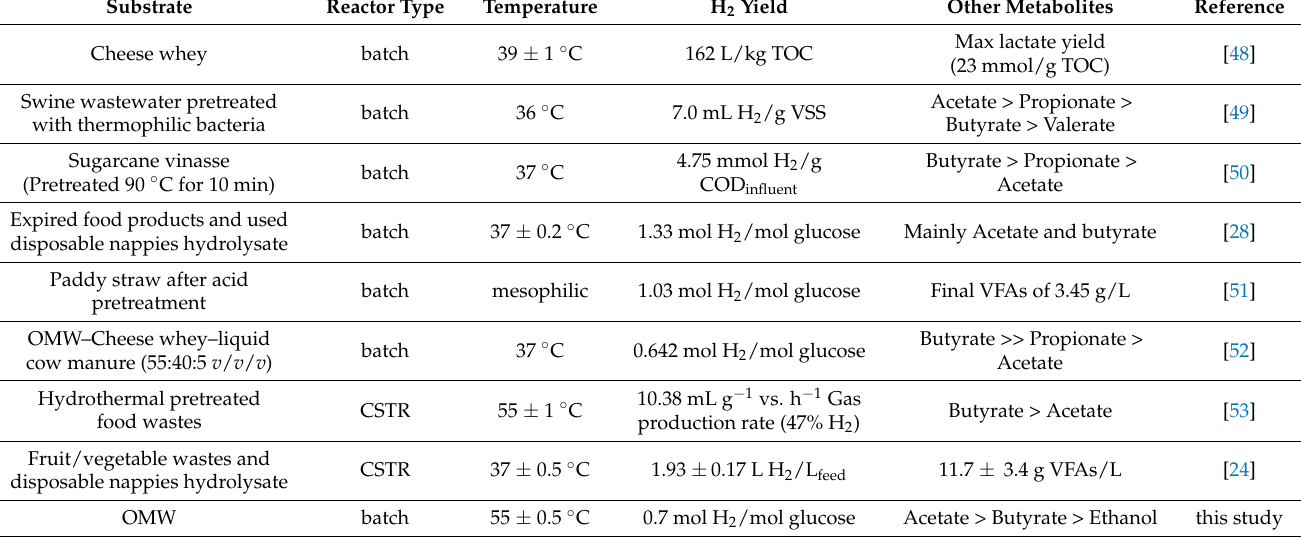
Table 5. Optimal yields of various substrates under DF experiments, at pH value of